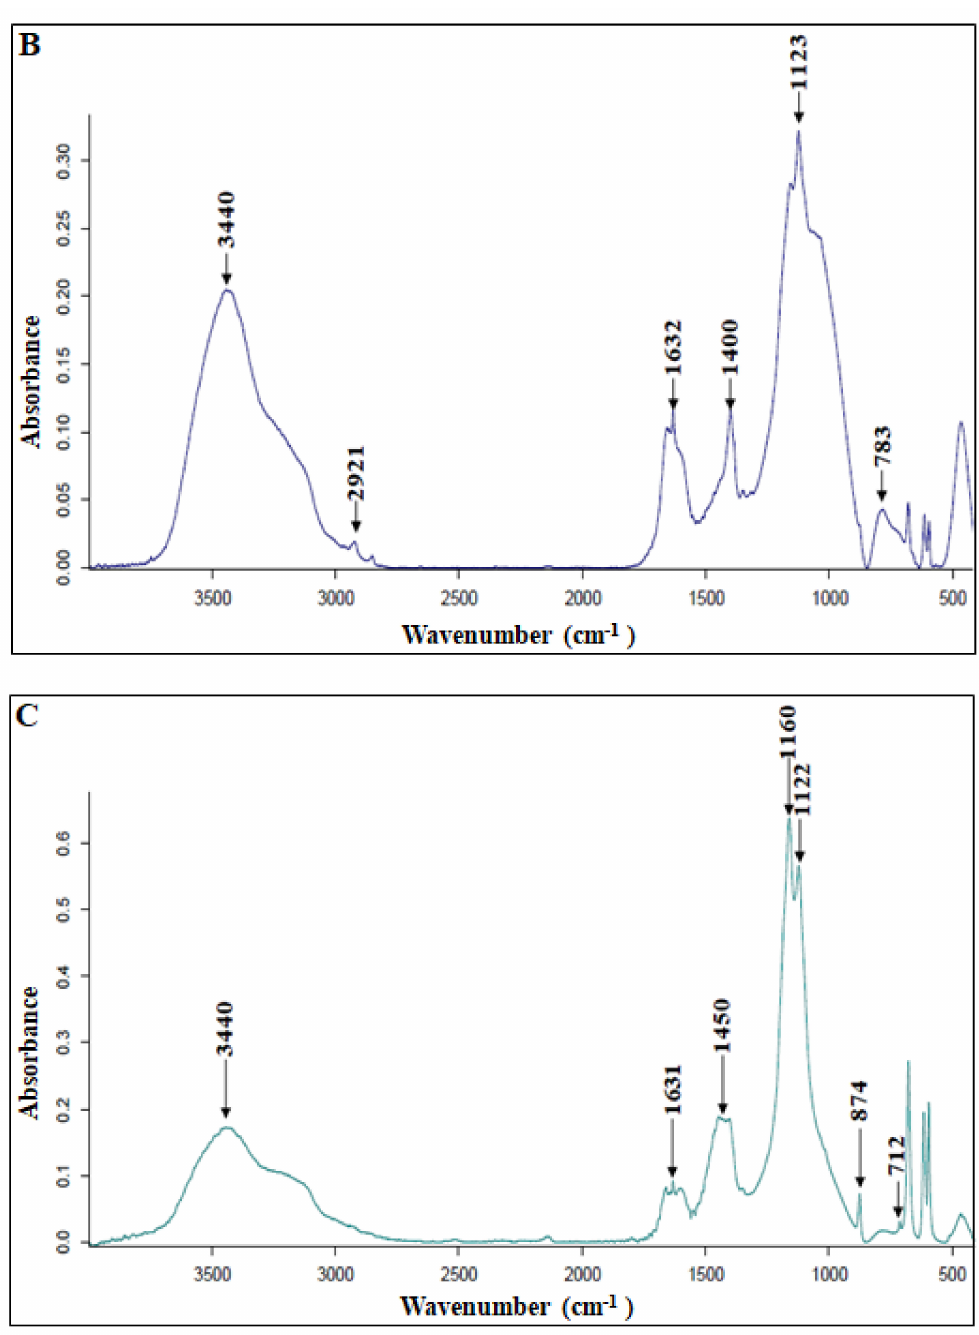
Figure 1. IR spectra of feedstock used ( A ): Textile waste, ( B ): Green waste, and ( C ): Paper and cardboard